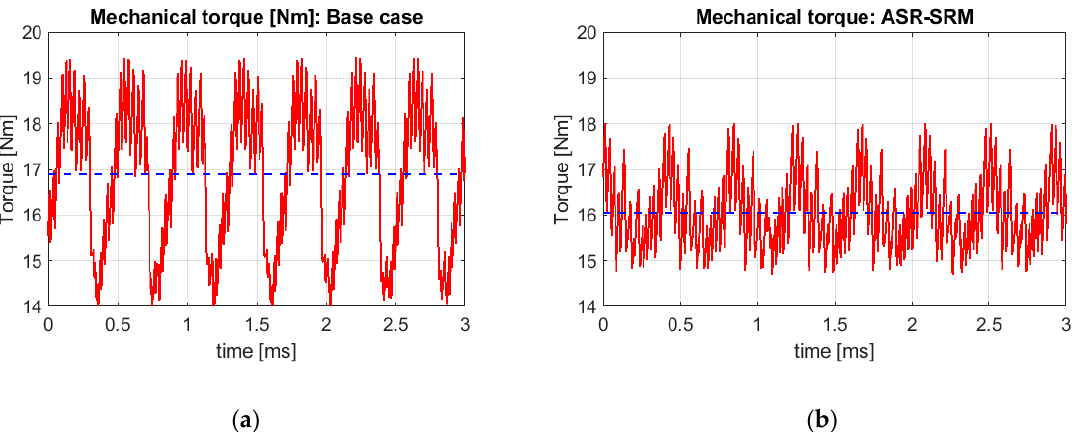
Figure 16. Mechanical torque developed at I = 260 A and ω = 12,000 rpm by: ( a ) the conventional configuration (base case); ( b ) proposed ASR-SRM configuration.